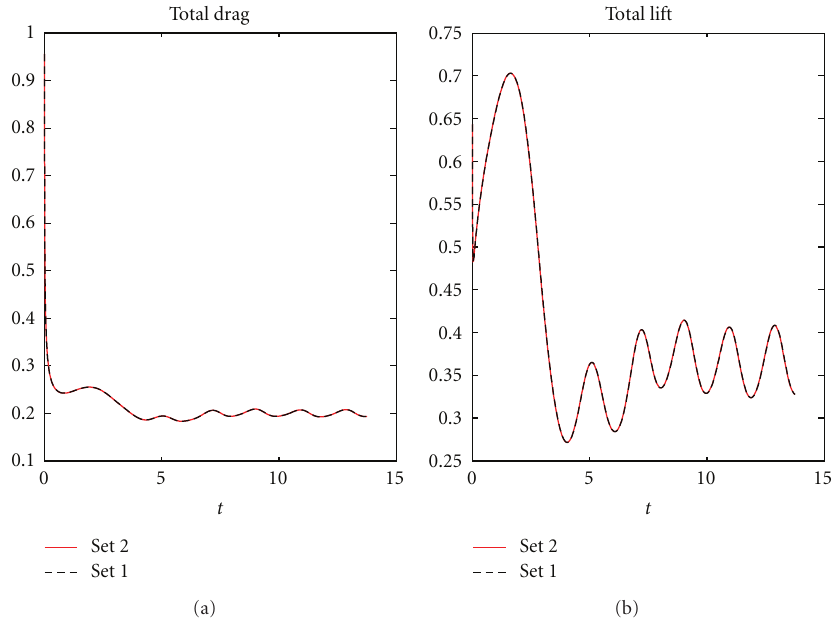
Figure 16: Total drag and total lift when using M = 3 and M =